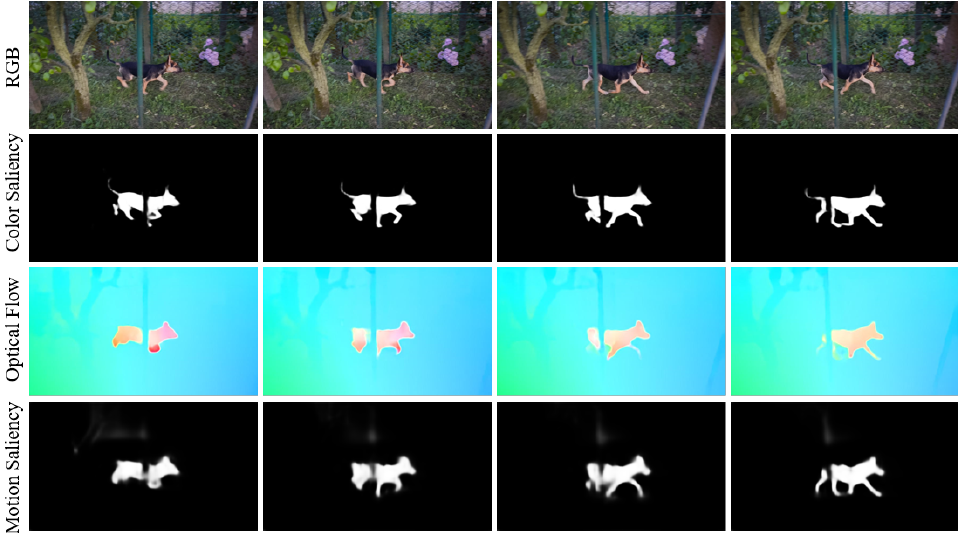
Figure 3. Color saliency is obtained from RGB images through the color saliency module, while motion saliency maps are obtained from optical flow maps through the motion saliency